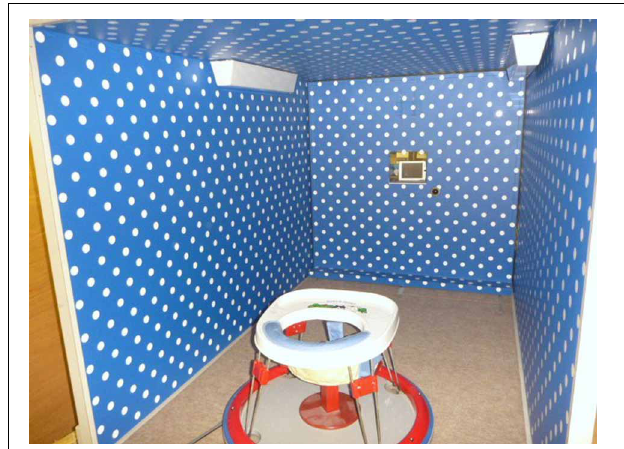
FIGURE 1 | The moving room. Responsiveness to peripheral optic flow is determined by cross-correlating the infant’s postural sway in the fore-aft direction, measured by four force transducers under the legs of the infant seat, with the movement of the side